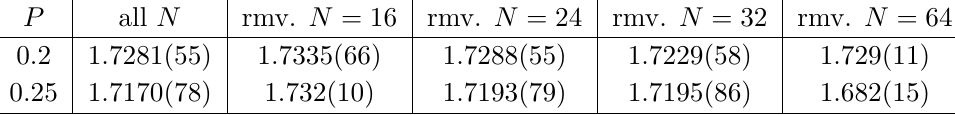
Table 4. Values of c con for W con with data for different N removed. With n t = 16 .